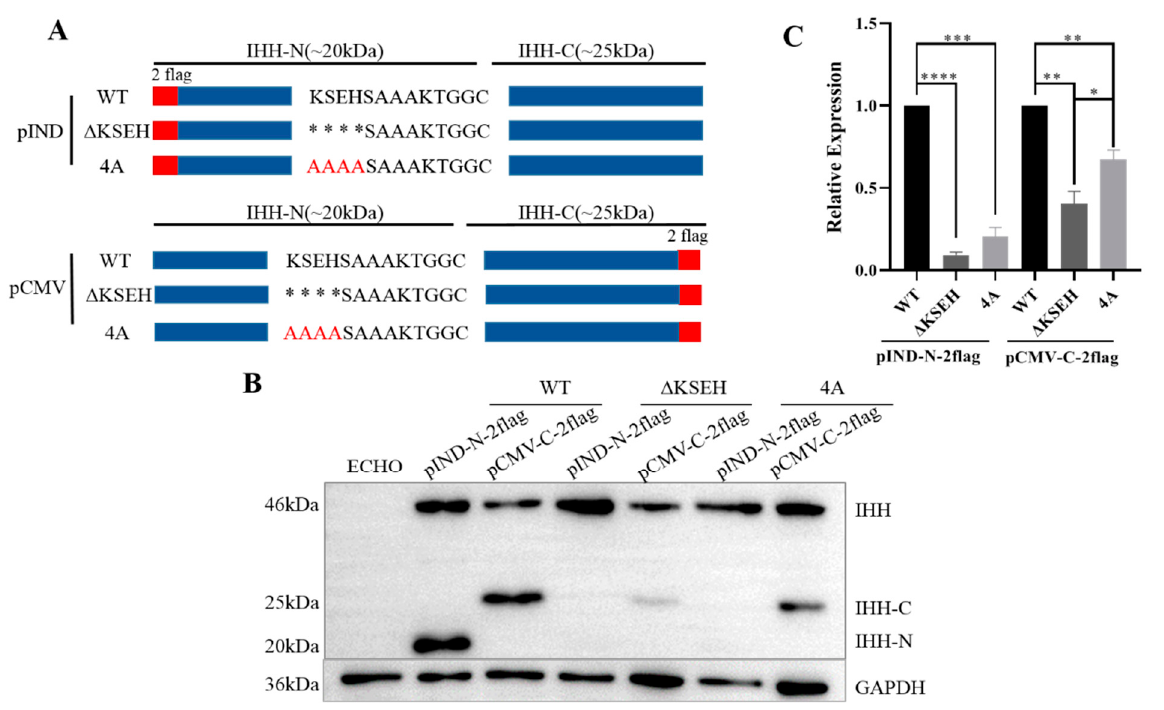
Figure 3. K191, S192, E193, and H194 are required for IHH self-cleavage. ( A ) Schematic of Δ KSEH and 4A constructs. Red letters indicate replaced amino acids; * truncated amino acids. ( B , C ) Western blot and statistical analysis showed that IHH-N was absent in Δ KSEH and 4A compared with WT, whereas IHH-C was remarkably reduced, indicating that IHH self-cleavage was considerably affected. Data are mean ± s.e.m, n = 3, * p < 0.05, ** p < 0.01, *** p < 0.001, **** p < 0.0001.